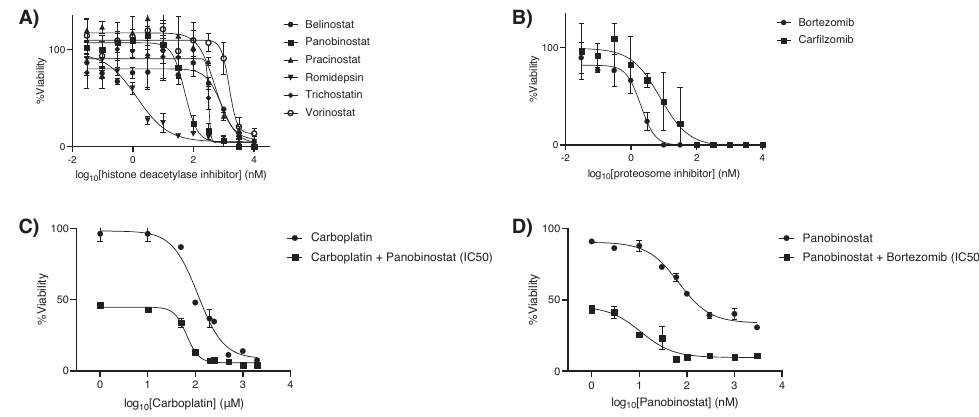
( A ) Dose-response curves for histone deacetylase and ( B ) proteasome inhibitors. ( C ) Dose-dependent cytotoxicity of carboplatin as a single-agent and in combination with panobinostat at the EC50 (67.4 nM), and ( D ) panobinostat in combination with bortezomib at the IC50 (5.2 nM). Addition of panobinostat at 67.4 nM potentiated the cytotoxic effect of carboplatin by shifting the EC50 of carboplatin from 115 µ M to 65 µ M, whereas the addition of bortezomib 5.2 nM shifted the EC50 of panobinostat from 67.4 nM to 10.8 nM. Symbols represent % of cell proliferation as compared to untreated control cells, expressed as means (SEM) of three independent